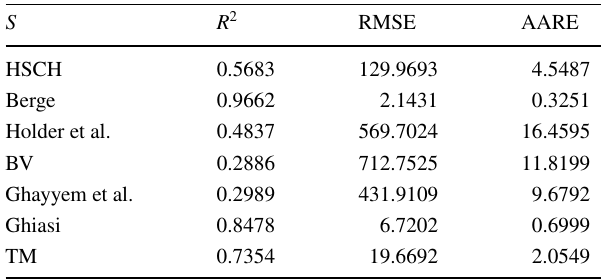
Table 8 Statistical error of HFP using empirical correlations for 259.1 ≤ T ≤